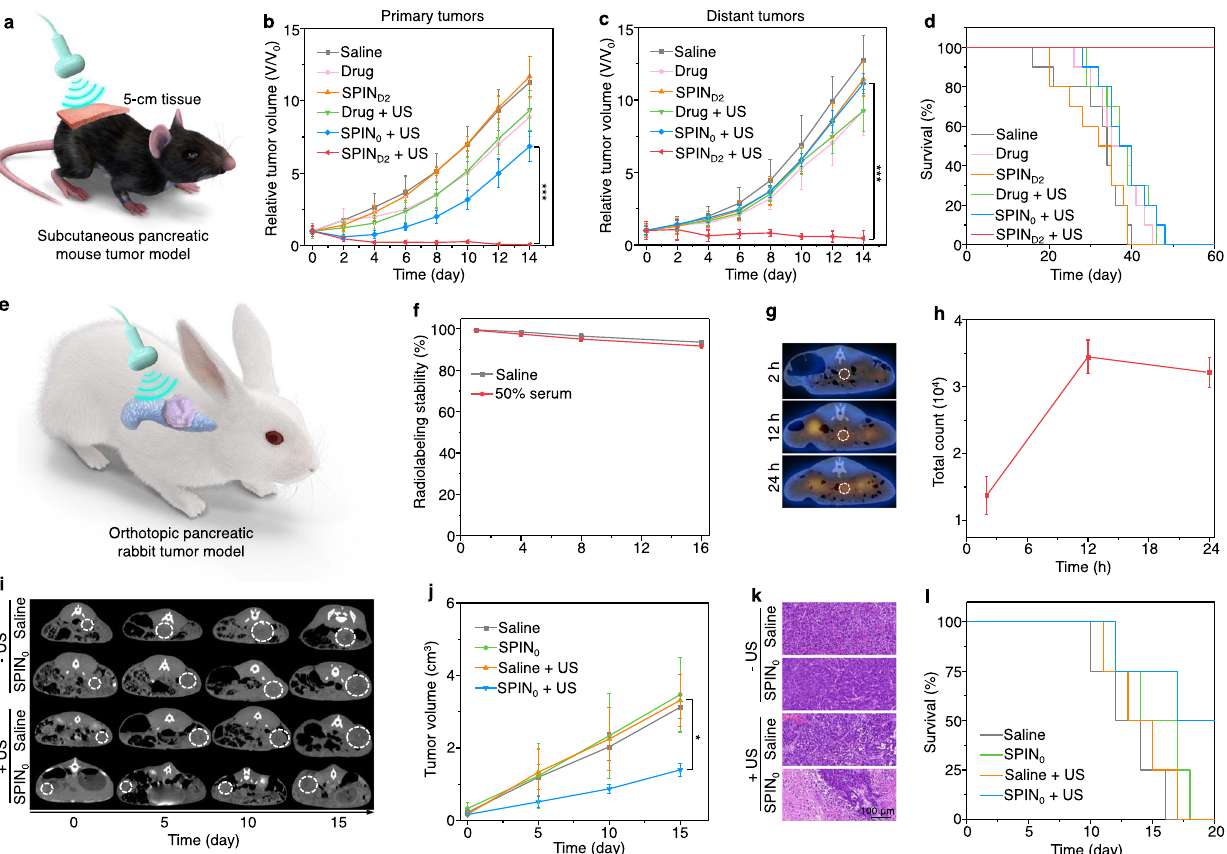
Fig. 5 Deep-tissue therapy of tumor models using SPINs. a Schematic of sono-immunotherapy of subcutaneous pancreatic mouse tumors covered with 5-cm tissue. b , c Relative tumor volumes of primary ( b ) and distant ( c ) tumors of Panc02 tumor-bearing C57BL/6 mice ( n = 5) after systemic injection of saline, free-drug mixture (on day 0, 3, and 6, 4 mg/kg body weight for NLG919 and aPD-L1), SPIN 0 or SPIN D2 (0.2 mL, 0.6 mg/mL) with or without US irradiation (1.0 MHz, 1.2 W/cm 2 , 50% duty cycle, 10 min). The primary tumors were covered with 5-cm tissue under US irradiation. SPIN D2 + US versus SPIN 0 + US: P < 0.0001 for primary tumors ( b ); SPIN D2 + US versus SPIN 0 + US: P < 0.0001 for distant tumors ( c ). d Survival curves of Panc02 tumor- bearing C57BL/6 mice ( n = 10) after different treatments for 60 days. e Schematic of US-mediated deep-tissue sonodynamic therapy of orthotopic pancreatic rabbit tumors. f Radiolabeling stability of 131 I-SPIN 0 after storage in saline or 50% serum at 37 °C for different time ( n = 3). g , h SPECT imaging ( g ) and signal intensity ( h ) of orthotopic pancreatic rabbit tumors after systemic injection of 131 I-SPIN 0 (1.0 mL, 1.5 mg/mL) for different time ( n = 4). The white dotted circle indicated tumors. i Computed tomography (CT) imaging of orthotopic pancreatic rabbit tumors after systemic injection of saline or SPIN 0 (1.0 mL, 1.5 mg/mL) with or without US irradiation (1.0 MHz, 1.2 W/cm 2 , 50% duty cycle, 30 min). The white dotted circle indicated tumors. j Tumor volume of orthotopic pancreatic rabbit tumors ( n = 3) after treatments as indicated for different days. Saline + US versus SPIN 0 + US: P = 0.0108. k H&E staining images of orthotopic pancreatic rabbit tumors after different treatments. The experiment was repeated independently three times with similar results. l Survival curves of orthotopic pancreatic tumor-bearing rabbits ( n = 4) after different treatments for 20 days. Data are presented as mean values ± SD. Statistical signi fi cance was calculated via two-tailed Student ’ s t test; * P < 0.05, *** P < 0.001. Source data are provided as a Source Data fi